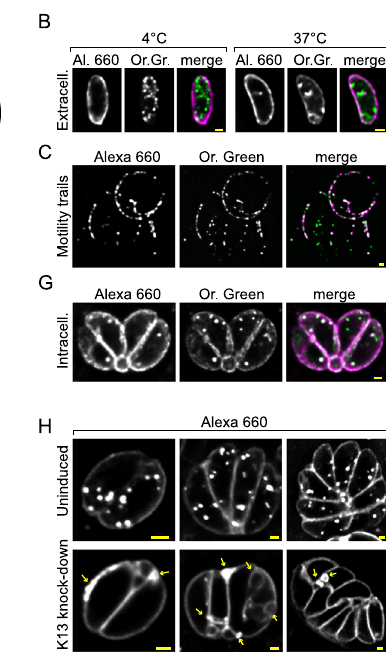
of differentially labelled extracellular cells (PM-SAG1 and Int-SAG1) viewed 24 h afterinvasion and intracellular growth. H Alexa660-labelled PM-SAG1 after 24h of growth without or with K13 depletion. Reduced uptakeofPM-SAG1 to intracellular vesiclesisquanti fi edas I percentageofparasiteswithinternalizedPM-SAG1( P value =7.75E − 16)and J theaveragenumberofPM-SAG1-positivevesiclespercell( P value = 1.13E − 12). K13-depleted cells showed accumulations of extra PM-SAG1-positive membranes (arrows in H) which occurred in a higher percentage of cells than for the uninduced controls ( K ) ( P value = 1.77E − 9). Three biological replicates were used for all analyses; All P values are 0 ≤ P ≤ 0.001, ***, error bars are standard deviations and the centre measurement of the graph bars is mean. Two-sided Student ’ s T -test was used for all the comparisons with no adjustments. All scale bars = 1 µ m. Source data are provided as a Source Data fi